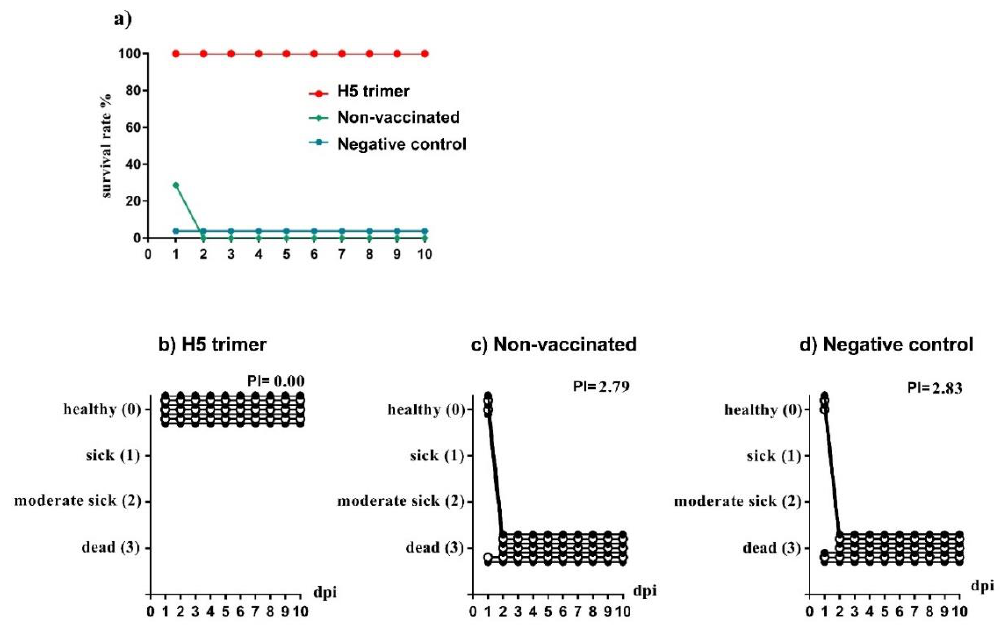
Figure 2. Purified H5-TG trimer protects chickens from HPAIV H5N1. Chickens immunized either with purified H5 trimer, or PBS, and non-vaccinated chicken were challenged with 10 7 plaque forming units of HPAIV A / duck / Vietnam / TG24-01 / 2005 (H5N1). Chicken survival rate was observed for 10 days after the viral challenges ( a ). Daily clinical scoring was recorded as following: 0 for healthy birds, 1 for birds with one clinical sign (depression, respiratory disorders, diarrhea, cyanosis of the comb or wattles, facial oedema or central nervous signs), 2 for birds that showed more than one clinical sign, and 3 for dead birds. The average scores of all animals per group and day post virus infection are indicated. The pathogenicity index (PI) was calculated as the sum of the daily arithmetic mean values divided by 10 (the number of observation days). ( b ) The PI of chickens immunized with purified H5 trimer, ( c ) The PI of non-vaccinated chickens, ( d ) The PI of chickens immunized with PBS. Dpi: day post viral inoculation.